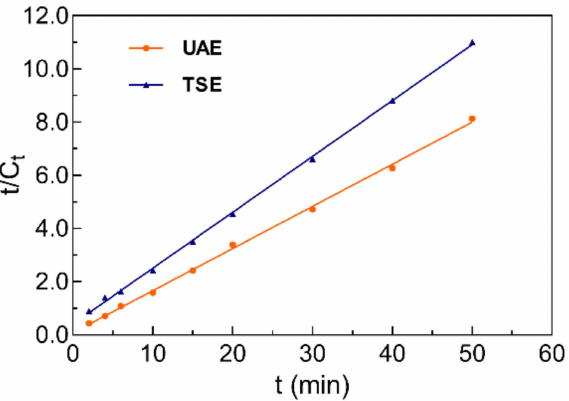
Figure 5. The relationship of t / C t vs. t from batch experimental extraction data of UAE and TSE.